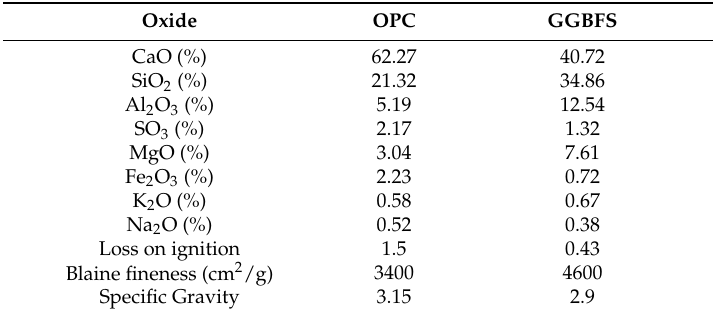
Table 1. Chemical composition and physical properties of ordinary Portland cement (OPC) and ground granulated blast furnace slag (GGBFS).